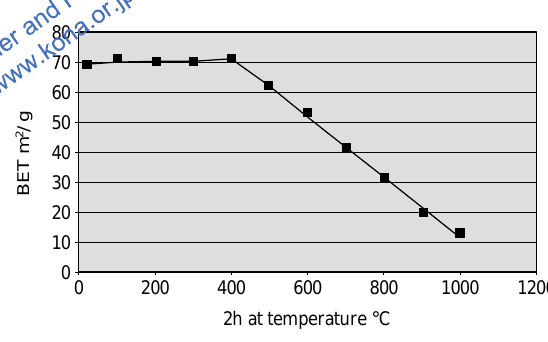
Fig. 17 Sintering behaviour of EP Zirconium Dioxide